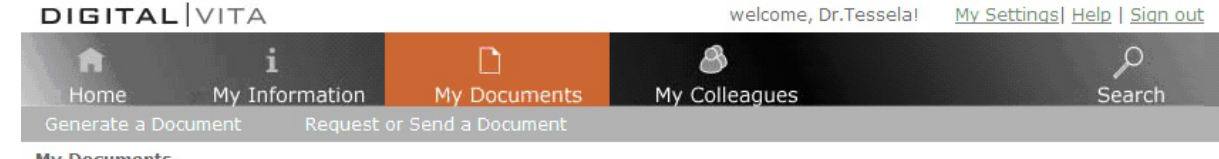
Figure 3. The My Documents component provides functions to output biographical information to several standard formats, customize information content, archive old versions, and include updates to biographical information